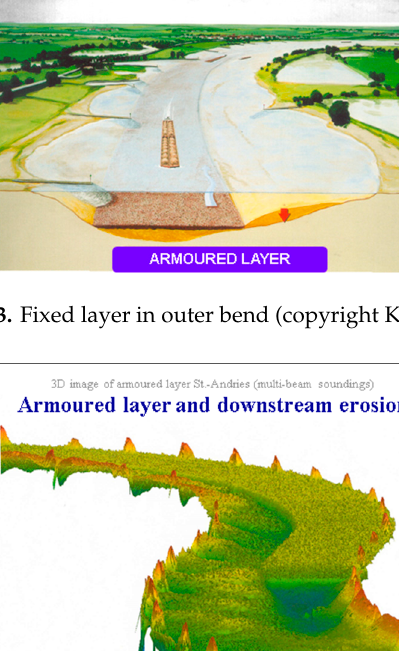
Figure 16. Increased navigation channel width at the St. Andries bend by fixed layer (at a depth of 2.5 m at ALW) (copyright RWS).